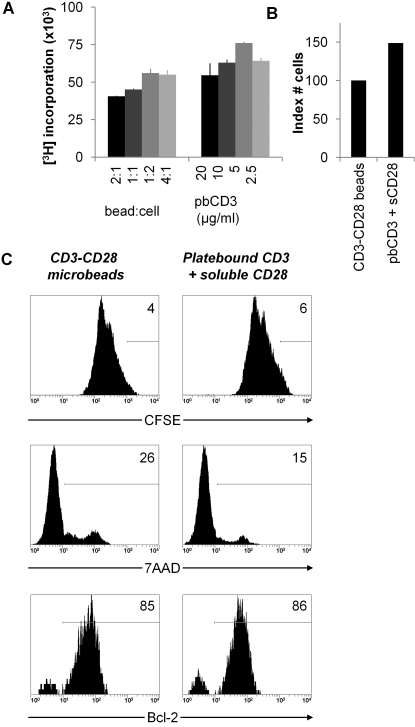
Determination of optimal mode and strength of secondary polyclonal Treg stimulation.(A) Treg were primed with anti-CD3+ anti-CD28 microbeads and restimulated with indicated ratios of anti-CD3+ anti-CD28 microbeads or with indicated concentrations of platebound anti-CD3+ soluble anti-CD28 in the presence of IL-2 and IL-15. Proliferation was determined by measurement of [3H]Thymidine incorporation at day 3. (B) Indexed cell yield after secondary polyclonal Treg culture using optimal strength of anti-CD3+ anti-CD28 microbeads (set to 100%) or platebound anti-CD3+ soluble anti-CD28 stimulation. (C) Cell division pattern and survival/death signals of Treg after different secondary polyclonal stimulations. Treg were stained with CFSE and stimulated with optimal strength of anti-CD3+ anti-CD28 microbeads or platebound anti-CD3+ soluble anti-CD28. CFSE dilution pattern, 7AAD staining and Bcl-2 expression of Treg population were assessed at day 4. Data are representative of four independent experiments.